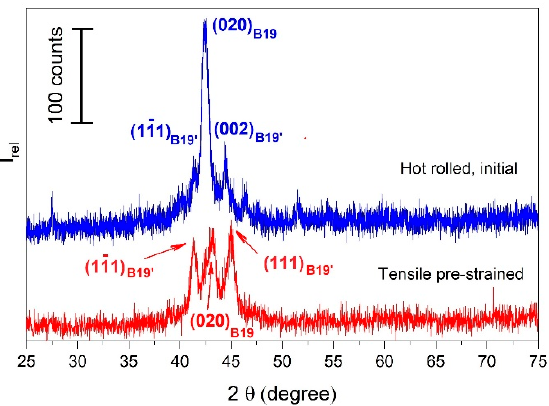
Figure 10. XRD patterns of specimens initial and elongated states, according to Figure 3c.